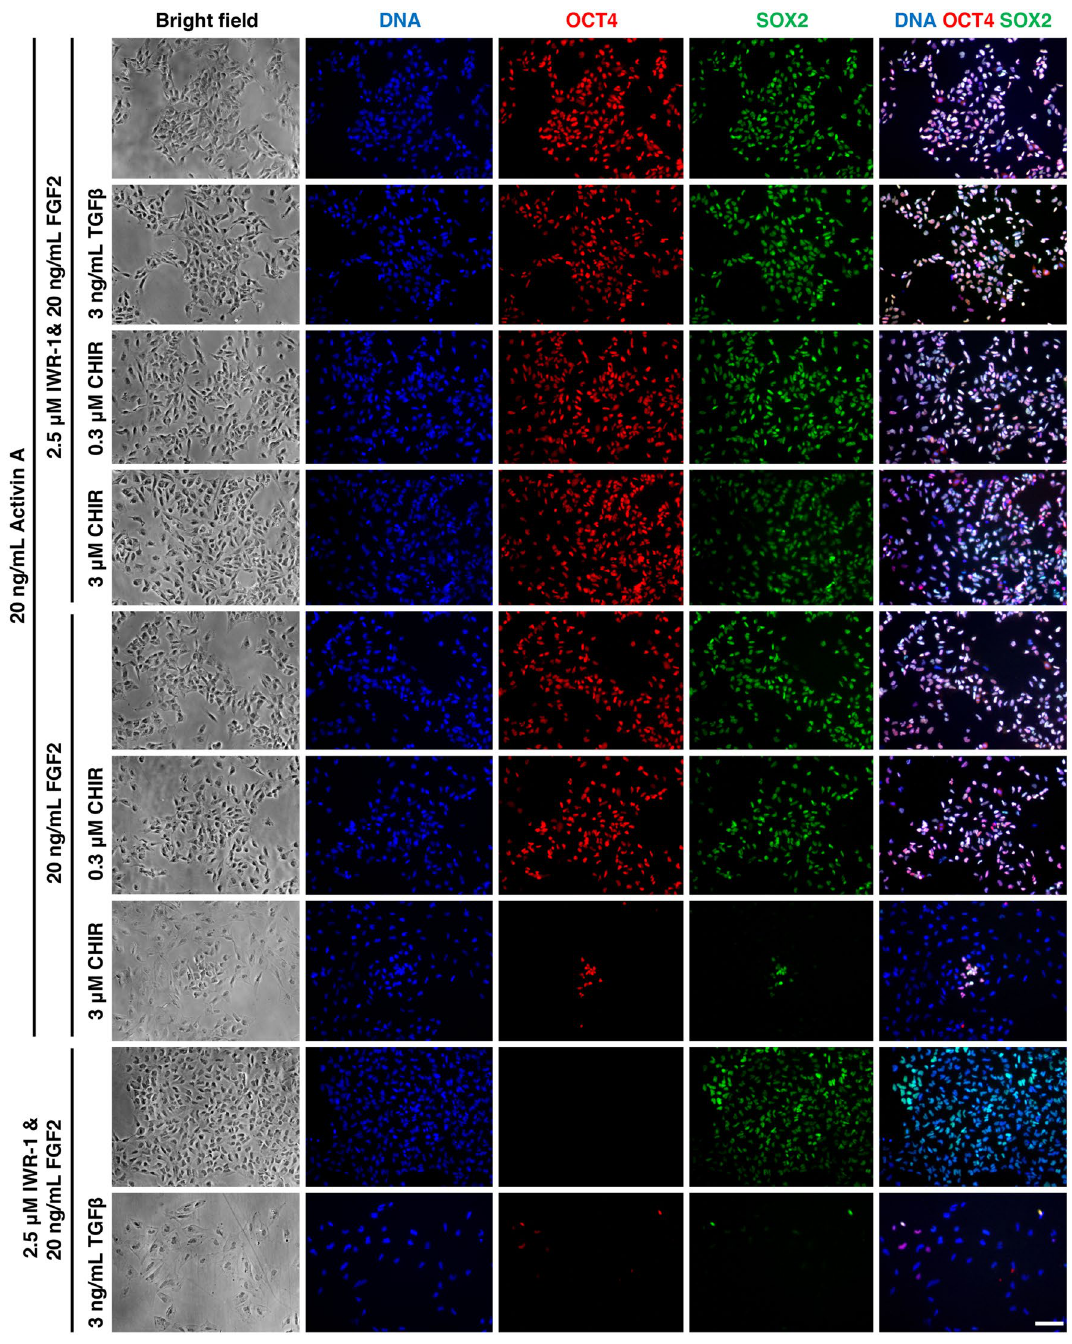
Figure 6. Feeder-free NBFR-bESCs depend on FGF2 and Activin A for pluripotency maintenance. Immunostaining of pluripotency factors OCT4 and SOX2 in NBFR-bESCs grown in feeder-free conditions supplemented with different combinations of Activin A, CHIR2291, FGF2, IWR-1 and TGFβ1 for 4 passages. Scale bar 100 demonstrated to support the culture of PSCs in several other species, including cattle 8, 16, 24, 30 . Interestingly, even though Essential 6 is also based on DMEM/F12, it did not show the same potential for replacing custom mTeSR1, even after BSA supplementation. Besides DMEM/F12, Essential 6 and custom mTeSR1 media each consist of 5 and 17 other ingredients, respectively. Therefore, one or more of those 12 components, not included in Essential 6 medium (glutathione, L-Glutamine, defined lipids, thiamine, trace elements B, trace elements C, β-mercaptoethanol, BSA, pipecolic acid, LiCl, GABA, H 2 O), have roles on self-renewal and colony morphology of bESCs. BSA functions as a carrier of lipids and metal ions, as an antioxidant, and has roles in the metabolic activity, proliferation and survival of cultured cells 31 . The exact mechanism of action of BSA in supporting PSCs has